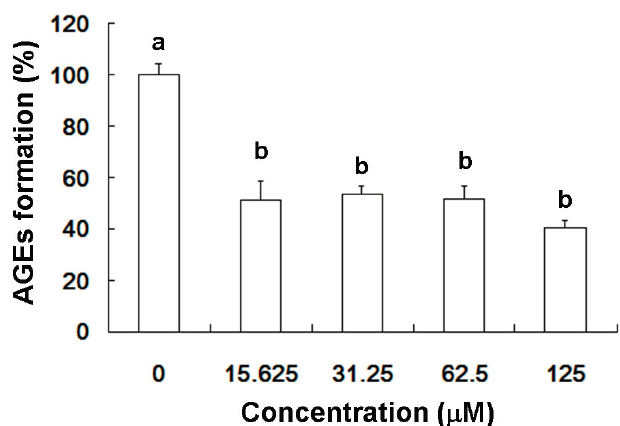
Figure 1. Inhibition of AGEs production by scopoletin (SP). Data here shown as mean ± SD ( n = 3). (a, b) indicate statistically significant differences p < 0.05.